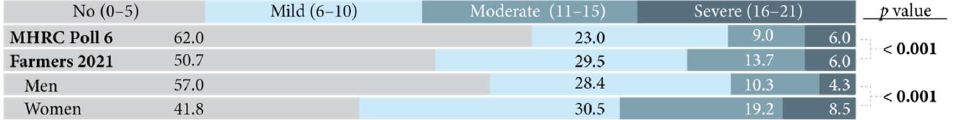
Figure 1. Classification of no, mild, moderate, and severe anxiety disorder symptoms for overall 2021 sample and by gender, in comparison to the Canadian general population during COVID-19 from